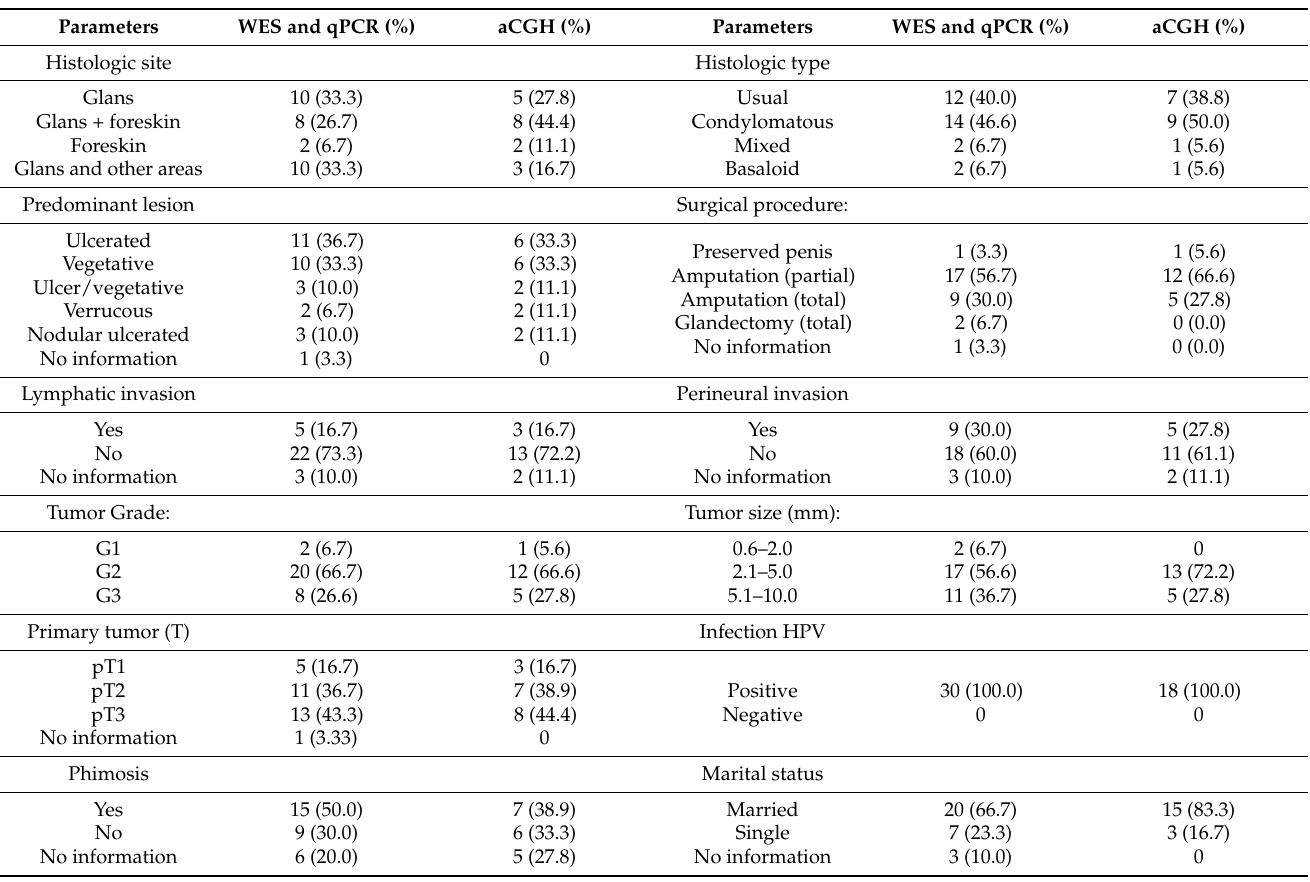
Table 1. Clinical and histopathological profile of 30 PSCC patients analyzed by WES, qPCR (CNA and gene expression), and aCGH (n =